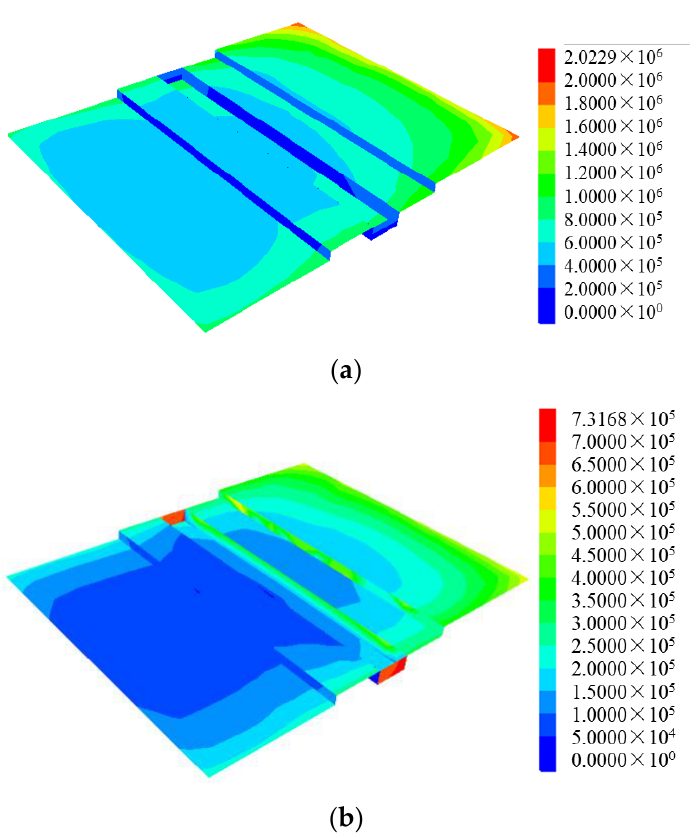
Figure 12. The contact stress on the rock-concrete interface. (Unit in Pa). ( a ) Normal stress; ( b ) Shear stress.